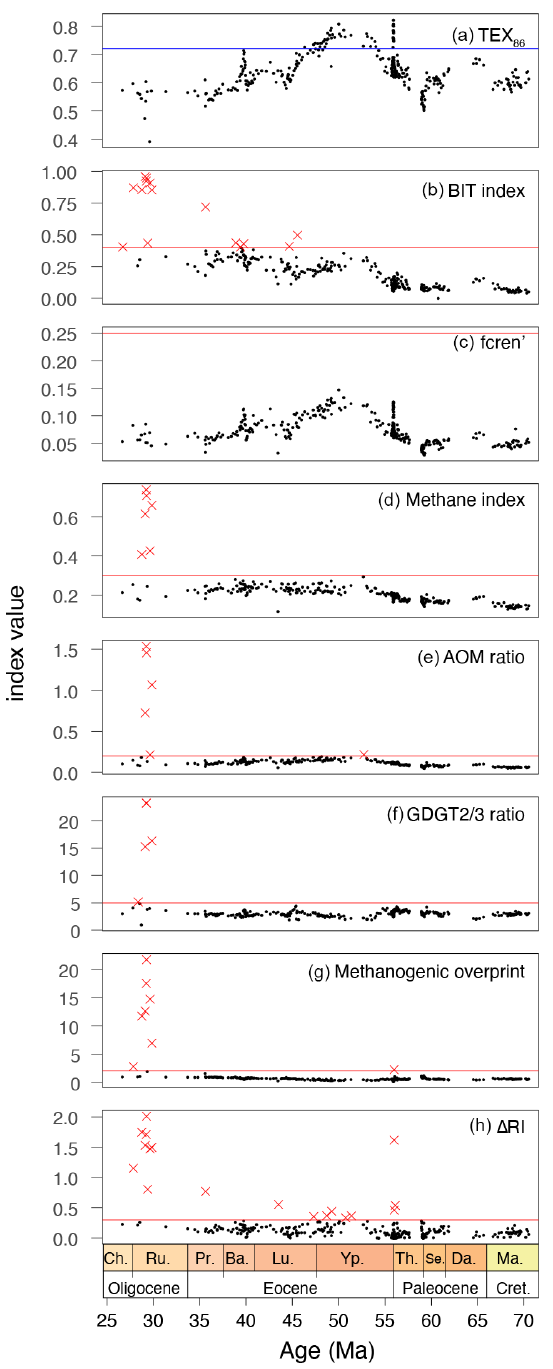
Figure 4. TEX 86 index and indices to identify overprints. For the equations of these indices, see Table 1. The red line indicates the cutoff value; red crosses indicate samples exceed the cutoff (a) TEX 86 (Schouten et al., 2002), with the blue line indicating the maximum modern core-top value ( ∼ 0.72). (b) BIT index (Hopmans et al., 2004). (c) fcren’ (O’Brien et al., 2017), no samples discarded. (d) Methane index (Zhang et al., 2011), n discarded = 6. (e) AOM ratio (Weijers et al., 2011), n discarded = 6. (f) GDGT-2 / 3 (Taylor et al., 2013), conservative cutoff of 5, n discarded = 4, one sample retained for absence of anomalous Ring index values (see text). (g) Methanogenesis (Blaga et al., 2009), cutoff of 2.0, n discarded = 8. (h) (cid:49) RI n discarded = 18.